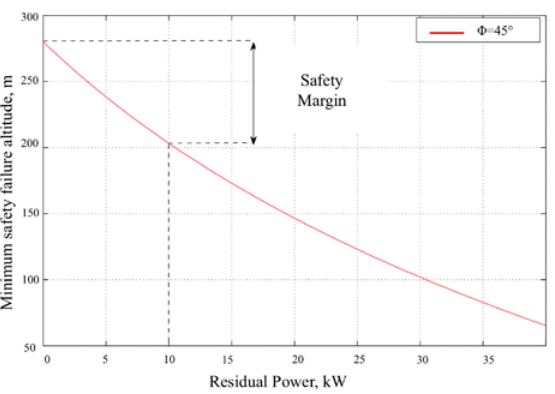
Fig. 15. Minimum safety height as a function of residual power